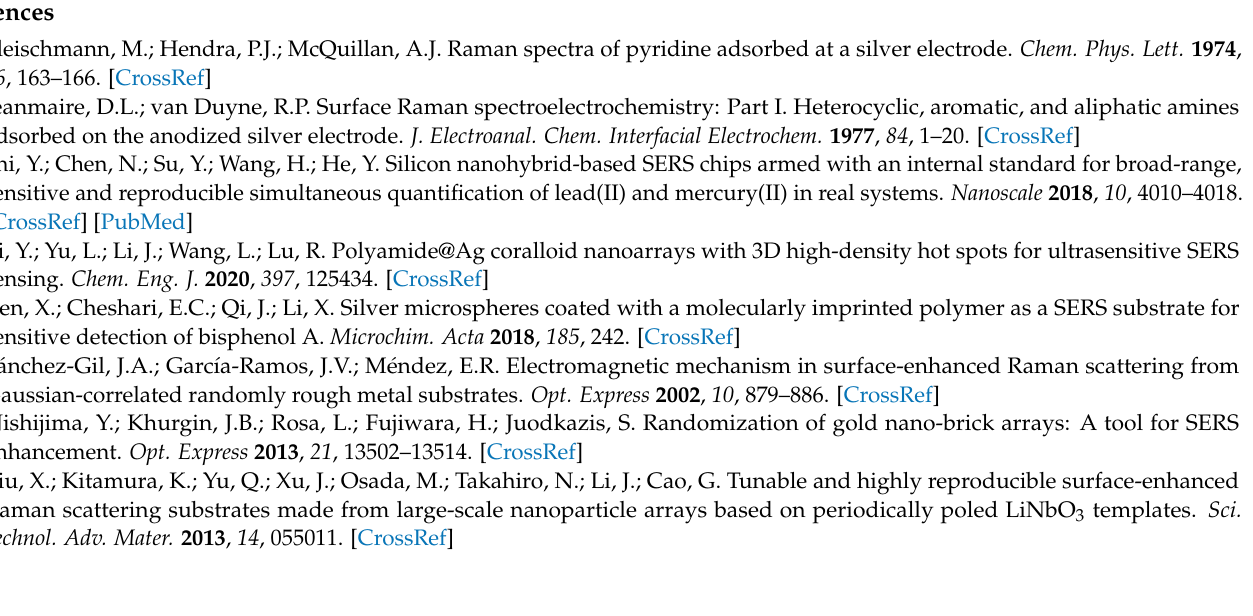
Figure S4: TEM image of the Au-Ag-ANPs; Figure S5: EDS measurement on the Au-Ag-ANPs; Figure S6: Photographs of the synthesized Au-Ag-ANPs in powders (left) and colloidal solutions in acetone